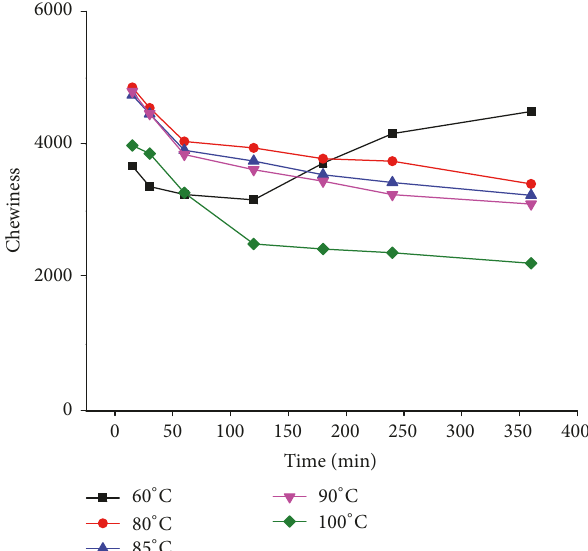
Figure 5: Chewiness changes during thermal